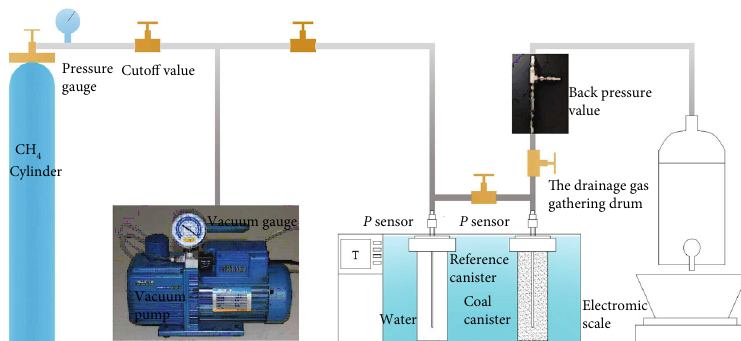
Figure 2: Desorption experiment device.